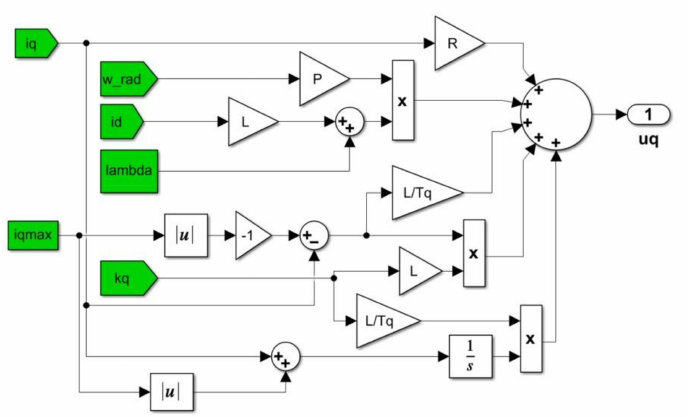
Figure 18. Block diagram of the MATLAB/Simulink implementation for the synergetic current controller of the u q command—Equation